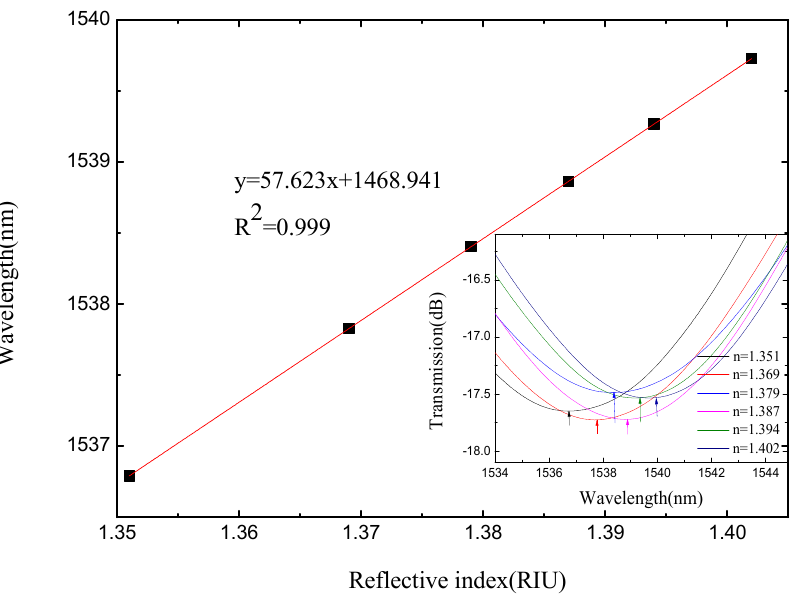
Figure 13. The sensitivity response characteristic diagram of SMS MZI.